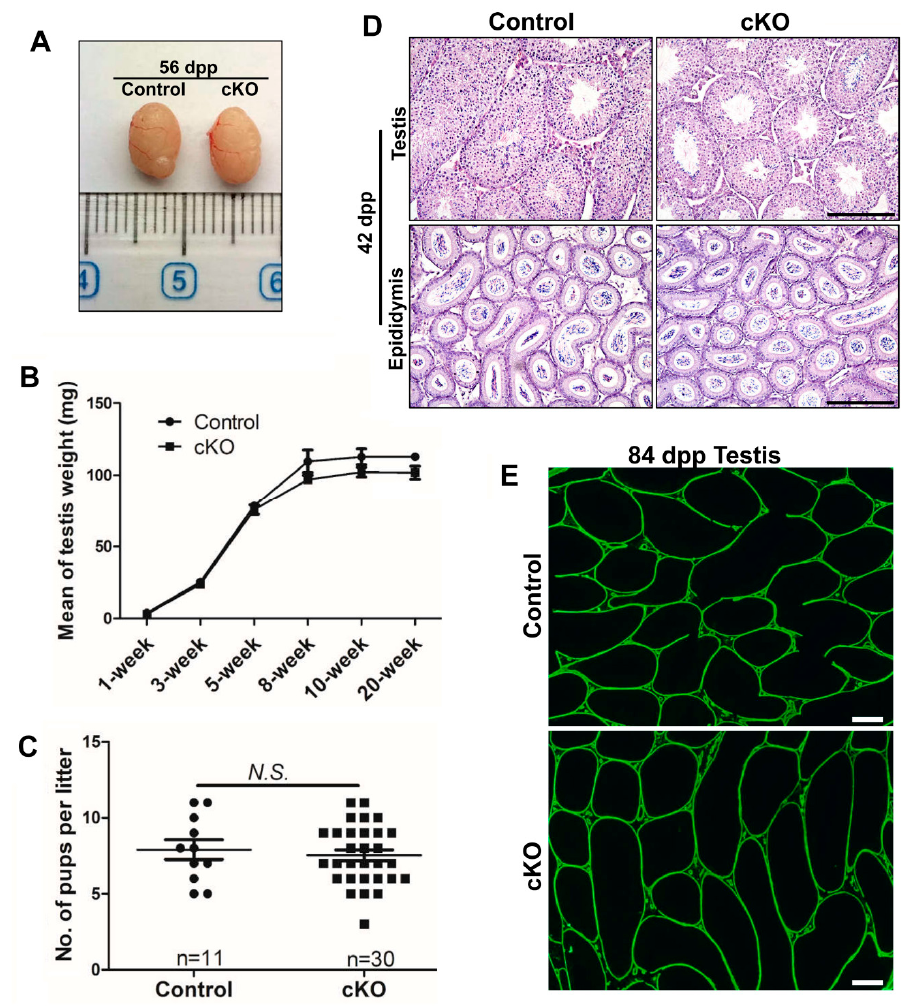
Figure 3. Partial deletion of Brg1 does not affect Sertoli cell development and spermatogenesis. ( A ) Representative images of testes from control littermates and cKO mice at 56 dpp. ( B ) Mean weight of testes from control and cKO mice at different ages, calculated from 3–10 animals per group. Data represent mean ± SEM. Statistical analyses were performed using Student’s t-test. ( C ) The number of pups per litter, calculated from 11 litters from 4 control mice and 30 litters from 5 cKO males. Data represent mean ± SEM. Statistical analyses were performed using Student’s t-test. N.S .: no significance. ( D ) Histology study of testes and epididymides from control and cKO mice at 42 dpp. Scale bars: 200 μ m. ( E ) BTB permeability was assayed with the biotin tracer (green) in testes from 84 dpp mice. Scale bars, 200 μ m.